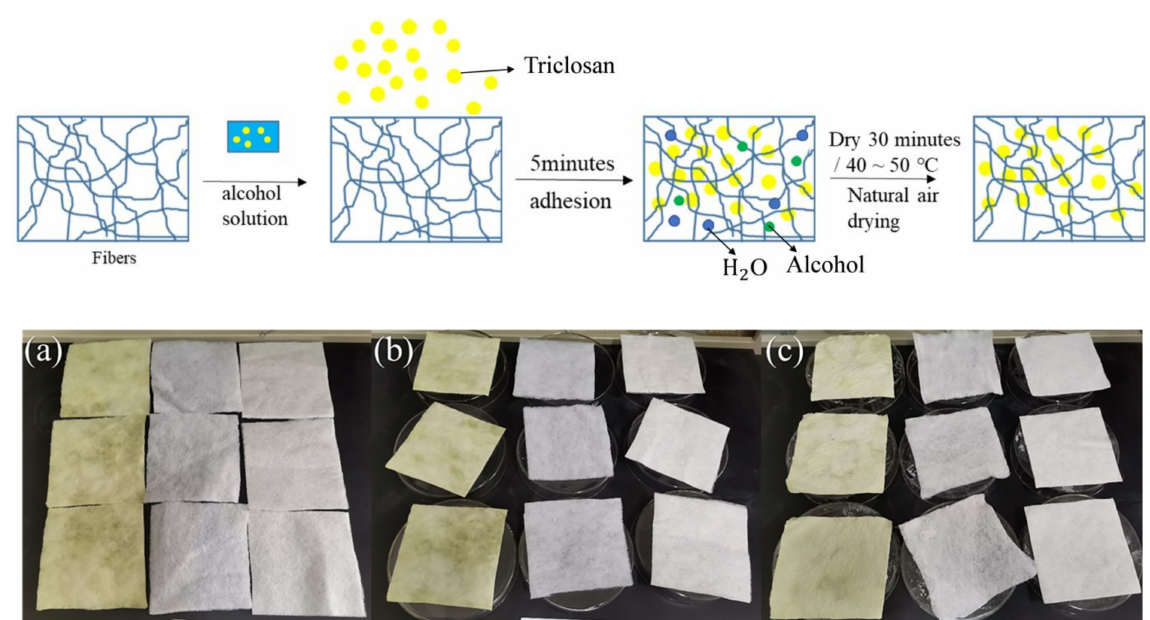
Figure 1. Preparation process for the filter materials treated with triclosan and the treated filter material (( a ) no treatment (NT), ( b ) alcohol-treated (AT), and ( c ) triclosan-treated (TT); in each set of images, the left is GF, the middle is NF and the right is